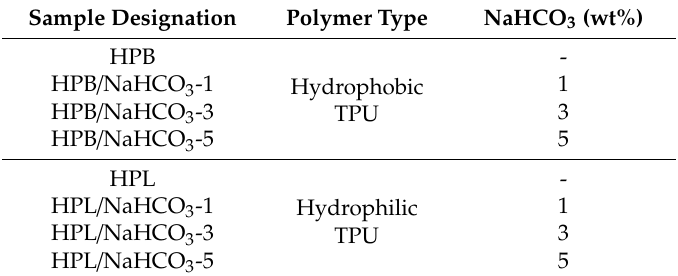
Table 1. Final formulations comprising hydrophobic TPU (HPB), hydrophilic TPU (HPL) and NaHCO 3 as the spore